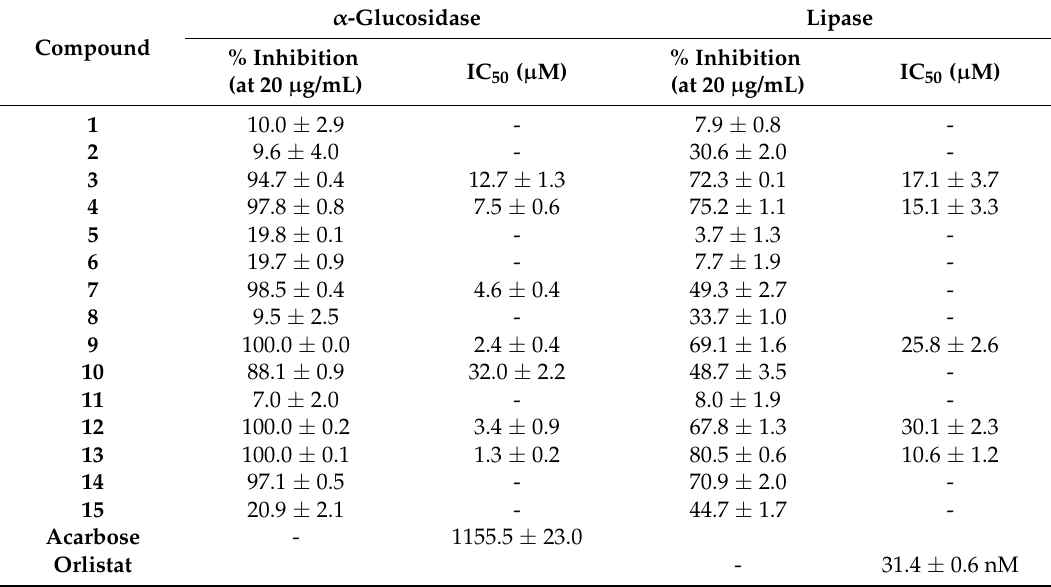
Table 2. α -Glucosidase and inhibitory activities of Compounds 1 – 15